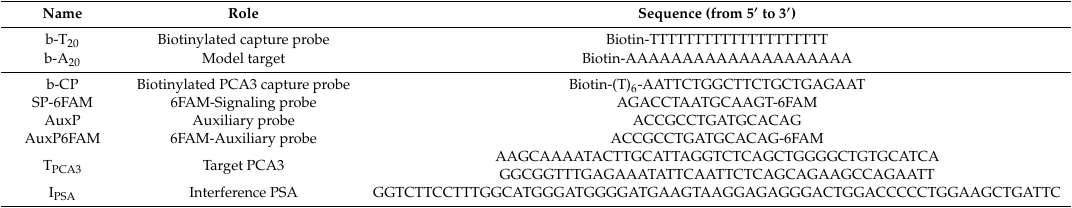
Table 1. Oligonucleotides used throughout the